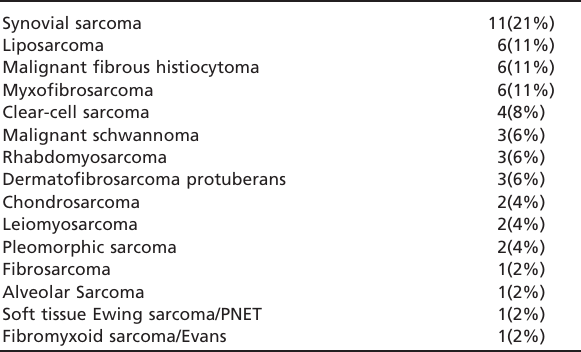
Table 2 - Histological type. Synovial sarcoma